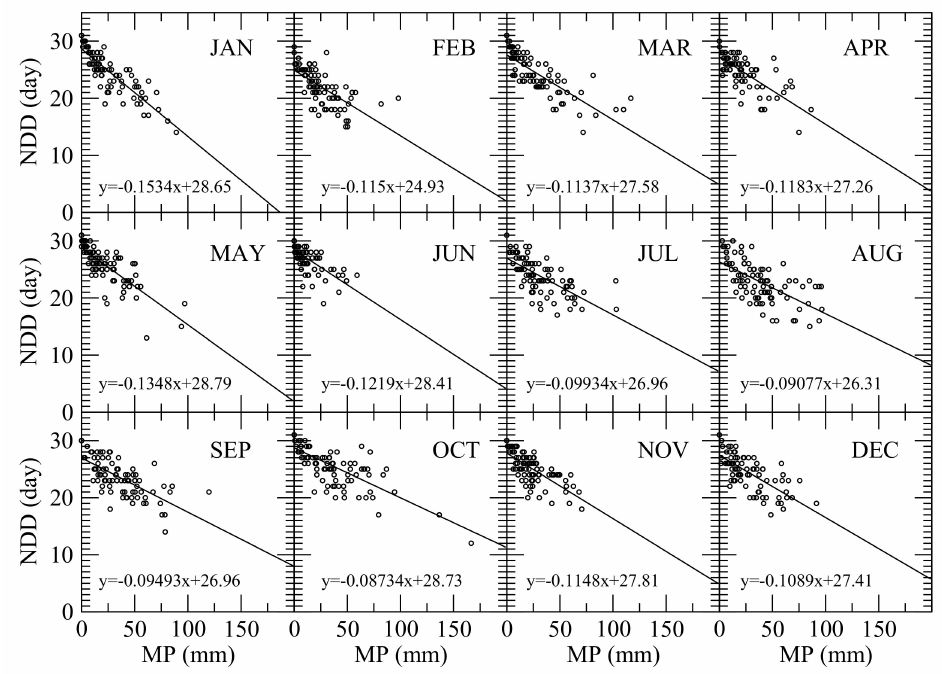
Figure 9. Scatter plots and the best-fit line of monthly precipitation (MP) vs. the number of dry days ( NDD ) in each